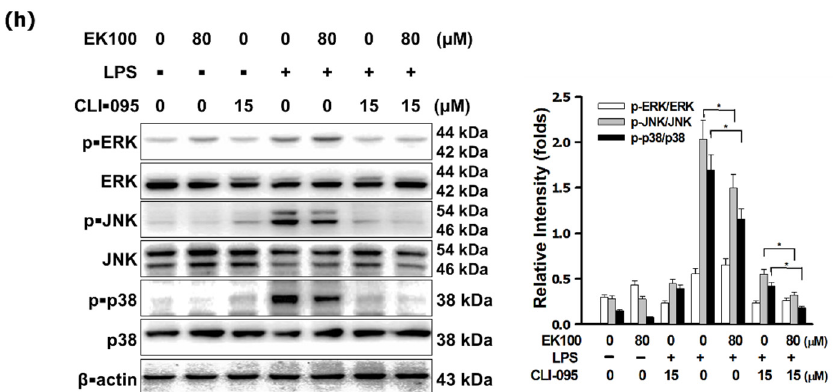
Figure 3. EK100 suppressed the MAPK/AP-1 pathways in LPS-stimulated RAW 264.7 cells. ( a ) Cells were treated with 0, 10, 20, 40, and 80 µM EK100 and then treated with 100 ng/mL LPS to evaluate the protein expression maximum peaks of p-ERK, p-JNK, and p-p38 in LPS-stimulated RAW 264.7 cells. ( b ) Cells were treated with 0, 10, 20, 40, and 80 µM EK100 for 1 h before being stimulated with LPS for 30 min. Then used WB analyzed MAPK protein levels ( c ). The protein expressions of transcription factor c-Jun and c-Fos in cytoplasm and nucleus were measured by WB. ( d ) Cells were treated with 80 µM EK100 for 1 h before being stimulated with LPS for 2 h. The localization and expression of c-Jun were measured by IF staining as designated in Materials and Methods. Cells were treated with EK100 and MAPK inhibitor (PD98095, SP600125, and SB203580) and TLR4 (CLI-095) for 1 h before being stimulated with LPS for 30 min. The protein expressions of p-ERK ( e ), p-JNK ( f ), p-p38 ( g ), and p-MAPKs ( h ) were detected by WB. Data presented as folds means ± SEM compared with β -actin in the cellular cytoplasm or PCNA in the cellular nucleus of three independent experiments ( n = 3). # p < 0.05 compared with the control group, * p < 0.05, ** p < 0.01, and *** p < 0.001 compared with LPS alone or group no EK100 treated group.